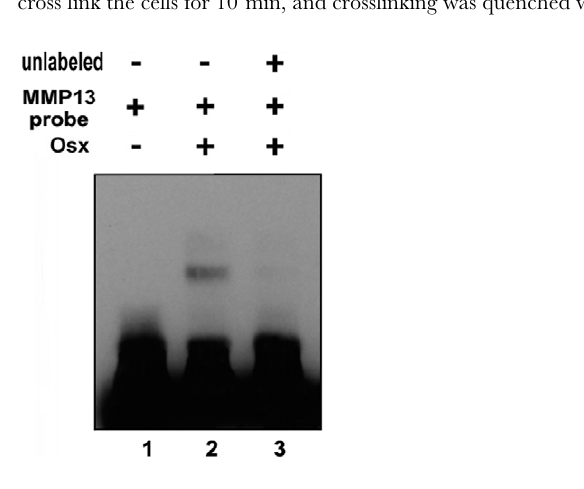
Figure 7. Osx binds to MMP13 promoter oligos in Gel Shift Assay. DNA oligonucleotides of MMP13 were labeled by Biotin. Osx protein and biotin-labeled DNA probe were incubated. Protein-DNA complexes were separated on 4% polyacrylamide gels, and visualized by a Chemiluminescent Nucleic Acid detection Module. Two hundred- fold molar excess of unlabeled MMP13 promoter oligos (lane 3) were used. Baculovirus-expressed Osx was used as the protein resource.